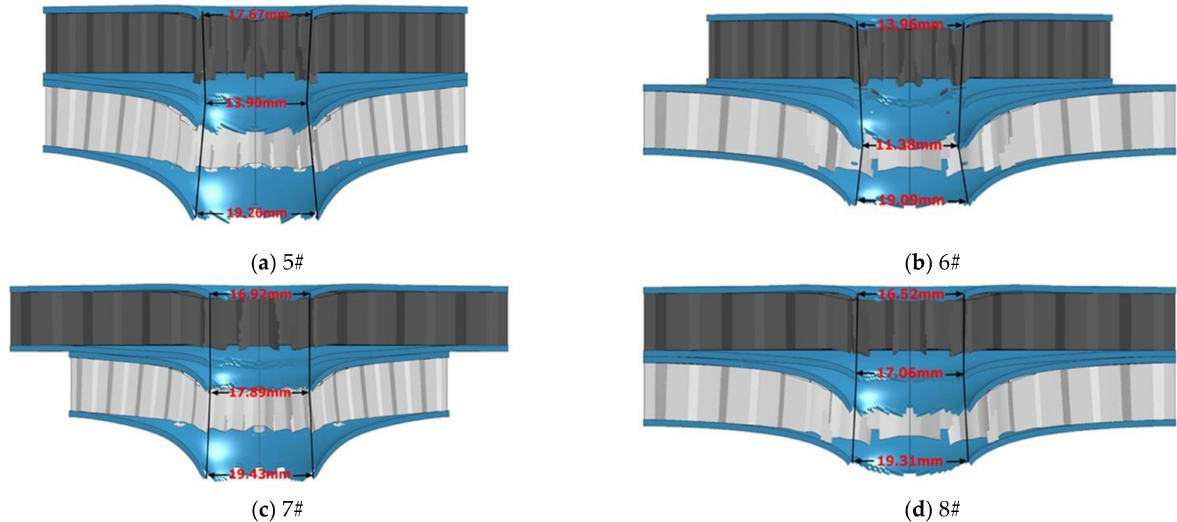
Figure 5. Damage results of 5#–8# structure. ( a ) Damage result of 5# structure; ( b ) Damage result of 6# structure; ( c ) Damage result of 7# structure; ( d ) Damage result of 8# structure.